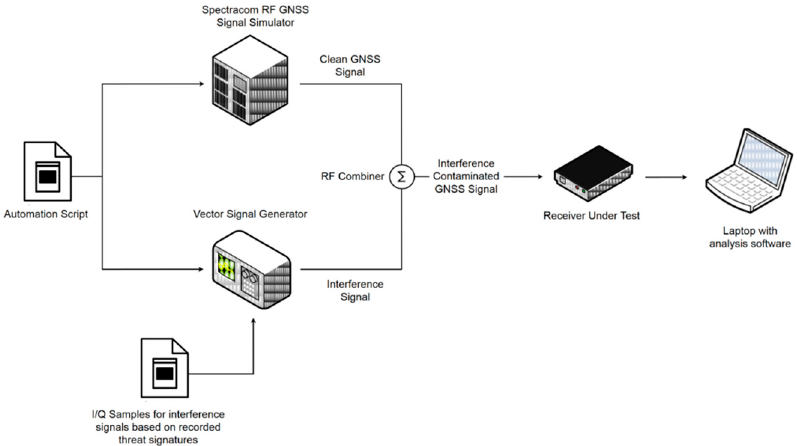
Figure 1. Receiver test platform .